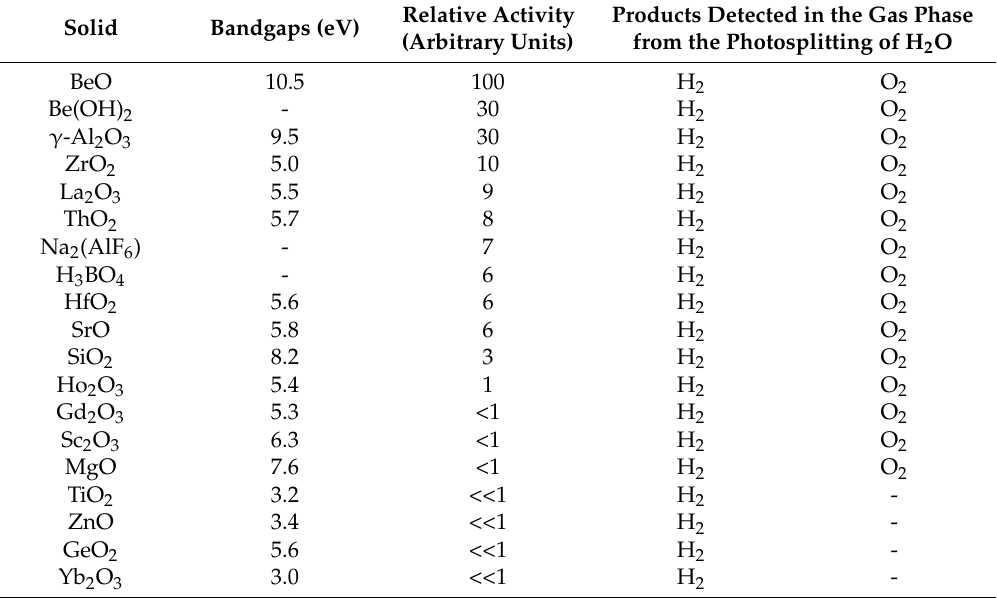
Table 1. Relative activities of dispersed solids used in the photodecomposition of adsorbed water with respect to the activity of BeO set arbitrarily at 100. Taken in part from Ref.